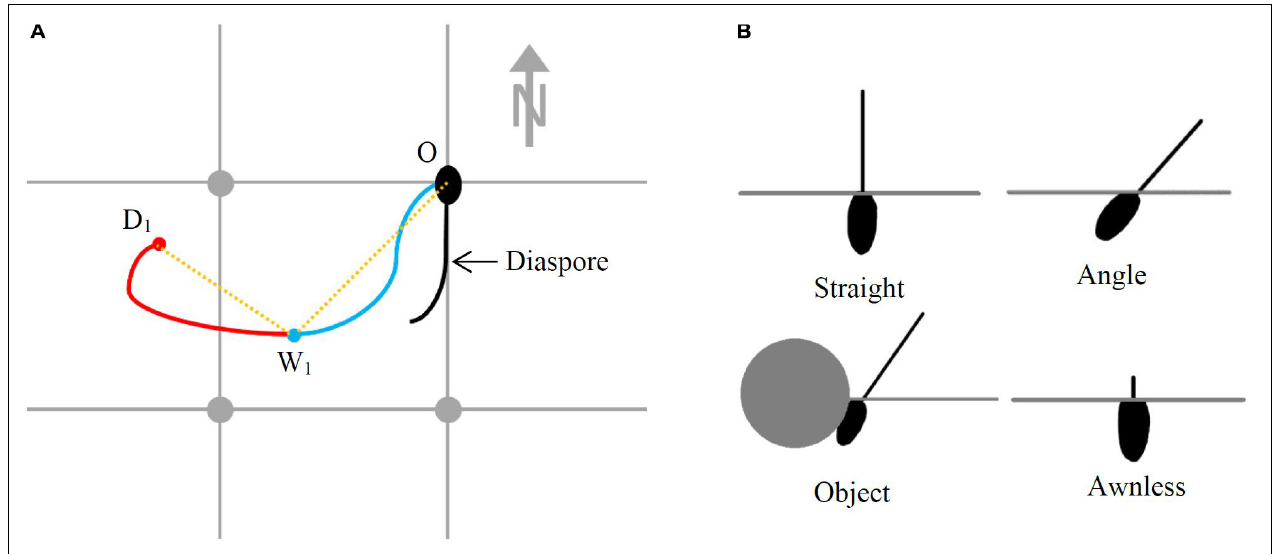
FIGURE 1 | Methods employed to study diaspore (A) surface dispersal and (B) burial. In (A) , O indicates the diaspore origin, W 1 is the location of the diaspore callus after the first wet cycle, D 1 is the location of the diaspore callus after the first dry cycle, the blue line is the movement path of the diaspore callus in the wet cycle, the red line is the movement path of the diaspore callus in the dry cycle and the orange dotted lines are the displacement lengths measured. In (B) , the horizontal lines indicate the soil